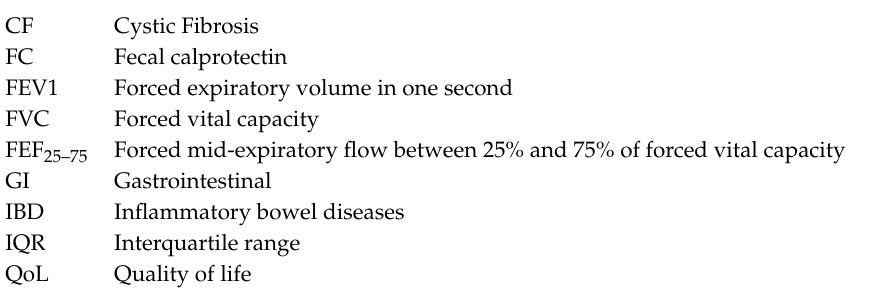
Table S1. Comparison and correlation of the Gastrointestinal Symptoms Scales 3.0-PedsQL TM and the Quality of Life Pediatric Inventory 4.0-PedsQL TM scores obtained from children and their parents. Table S2. Scores calculated from children’s and their parents’ answers to the Gastrointestinal symptoms scales 3.0-PedsQL TM . Table S3. Scores calculated from children’s and their parents’ answers to the Quality of Life Pediatric Inventory 4.0-PedsQL TM . Table S4. Comparison of fecal calprotectin levels between subgroups according clinical and functional outcomes. Table S5. Correlation between fecal calprotectin levels and clinical characteristics or lung function testing results. Table S6. Di ff erences between scores calculated from children’s and their parents’ answers to the Gastrointestinal symptoms scales 3.0-PedsQL TM according clinical parameters. Table S7. Di ff erences between scores calculated from children’s and their parents’ answers to the to the Quality of Life Pediatric Inventory 4.0-PedsQL TM according clinical parameters. Table S8. Significant correlations between clinical parameters or lung function testing results and PedsQL TM -Gastrointestinal symptoms scales 3.0 or PedsQL TM -Quality of Life Pediatric Inventory 4.0 scores obtained from children or their parents. Figure S1. Gastrointestinal Symptoms Scales 3.0-PedsQL TM “Food and drink limit” scores according answers obtained from children and their